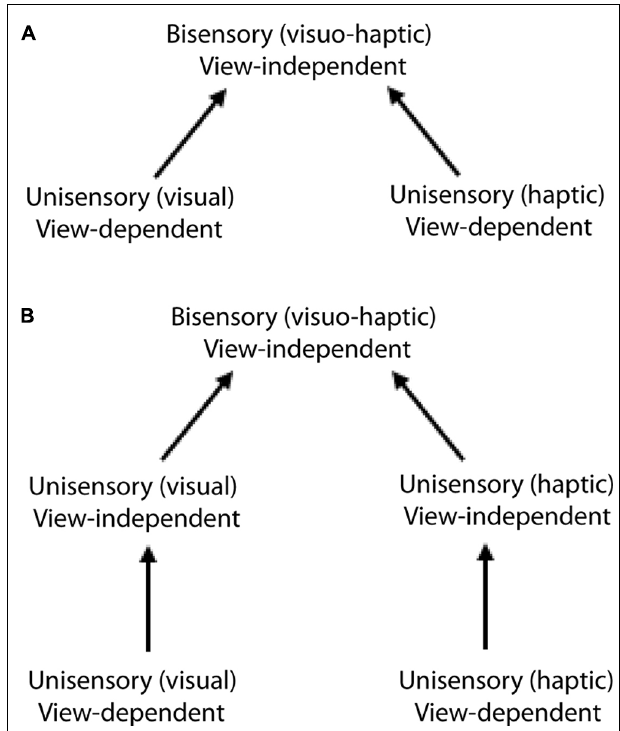
FIGURE 2 |Alternative models of visuo-haptic view-independence: (A) direct integration of the unisensory view-dependent representation into a multisensory view-independent representation; (B) bisensory view-independence gated by separate, unisensory view-independent representations. Evidence supports the direct integration model (A) . Figure adapted from Lacey etal.